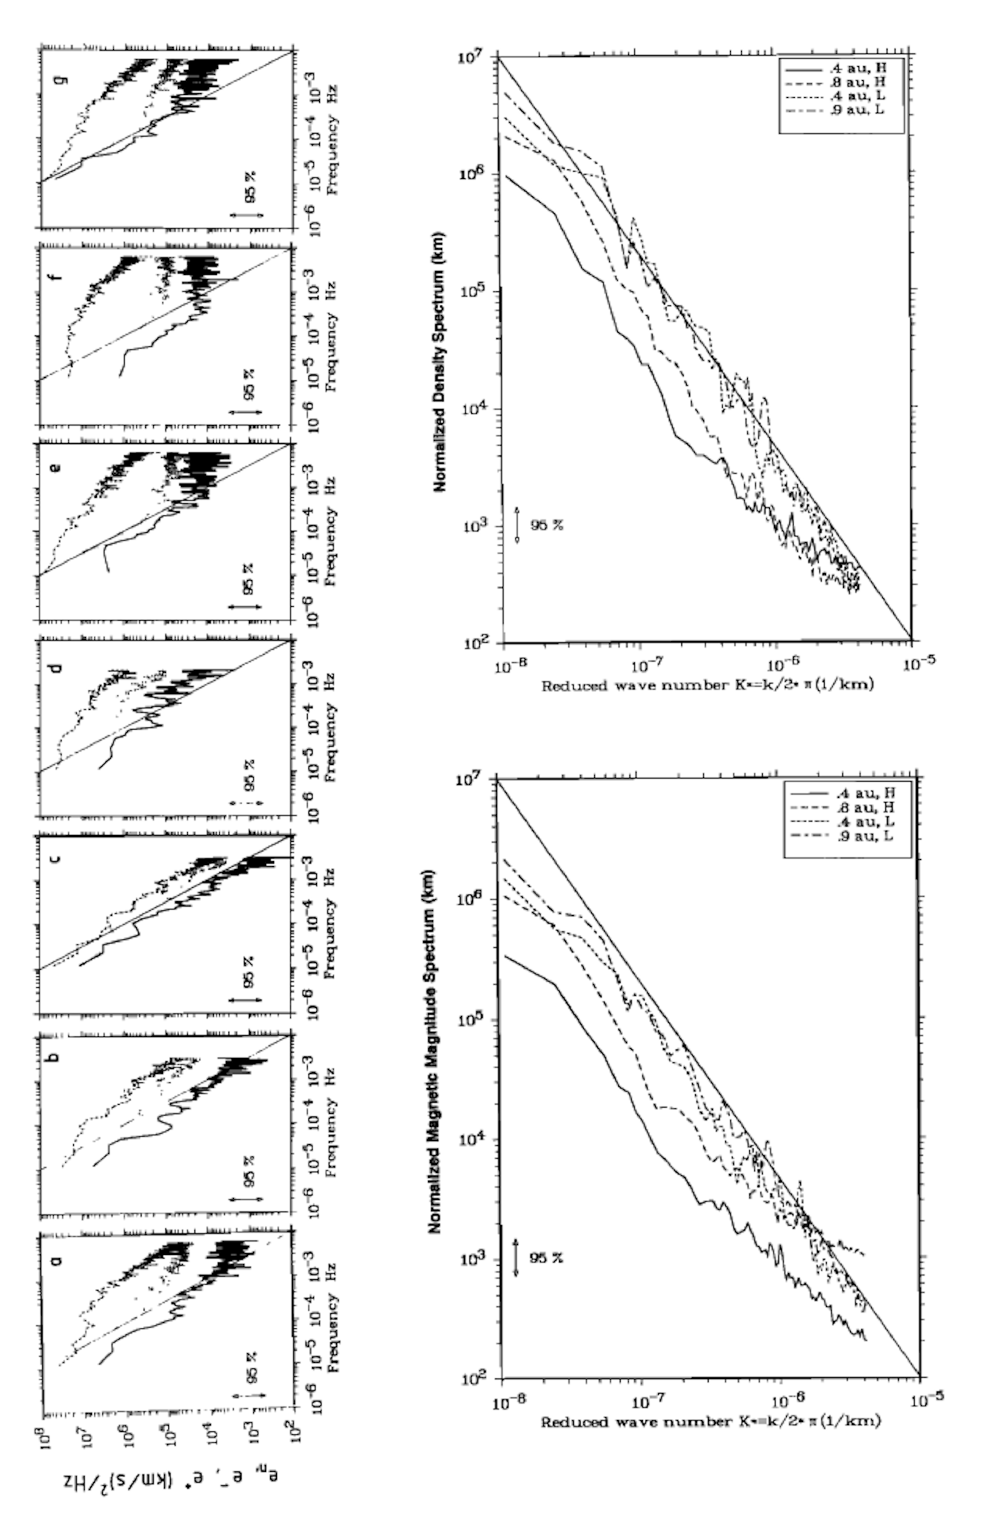
Figure 4. Composite figure that reproduces Figures 2, 6 and 7 of the article by Marsch and Tu (1990) [10]. Spectra of Z + and Z − are shown at different positions in both the fast and slow streams at 0.3 AU ( left part ); spectra of density and magnetic field intensity fluctuations at radial distances r = 0.4 AU and r = 0.8 AU in the fast speed streams ( right part ). Courtesy of John Wiley and Sons. Permission to reprint